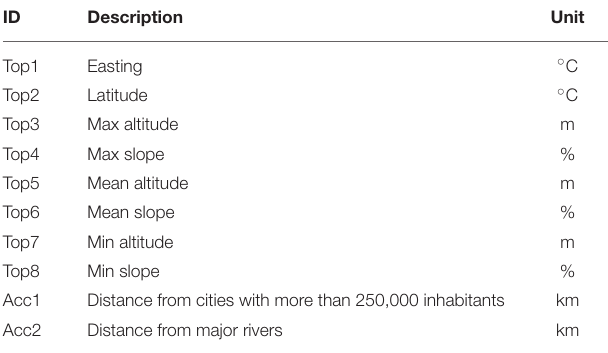
TABLE 1 | Bioclimatic environmental predictors. TABLE 2 | Topographic and accessibility